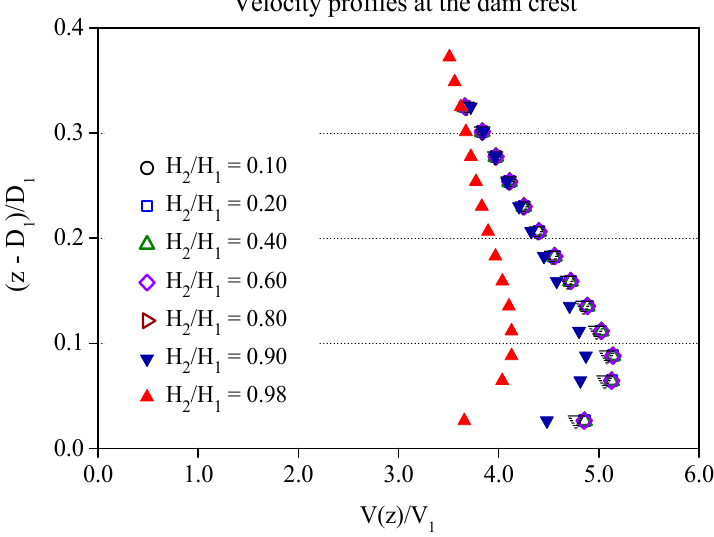
Figure 12. Profiles of time-averaged horizontal velocity above the crest (x = 0) of the circular dam of different depth ratios.